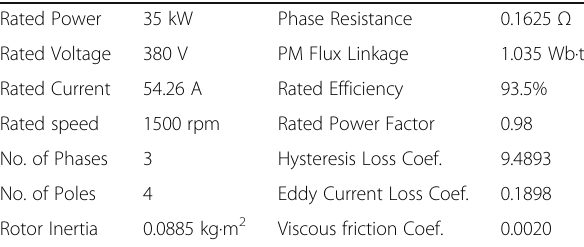
Table 3 Generator